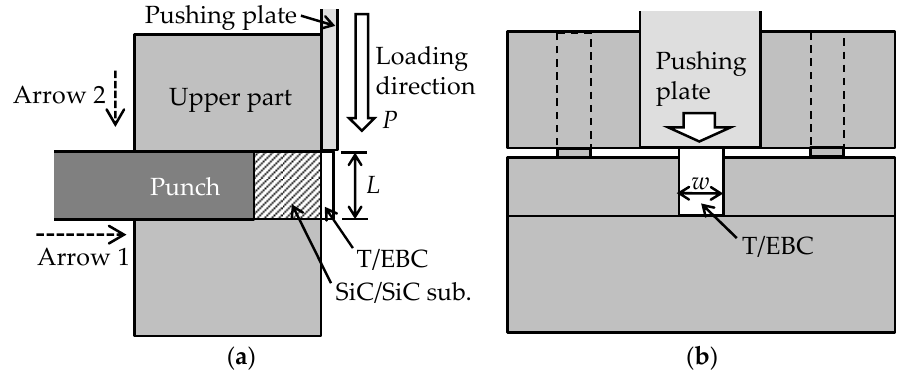
Figure 3. Schematics of experimental set-up of interface fracture test: ( a ) Cross-sectional side view; ( b ) Front view.